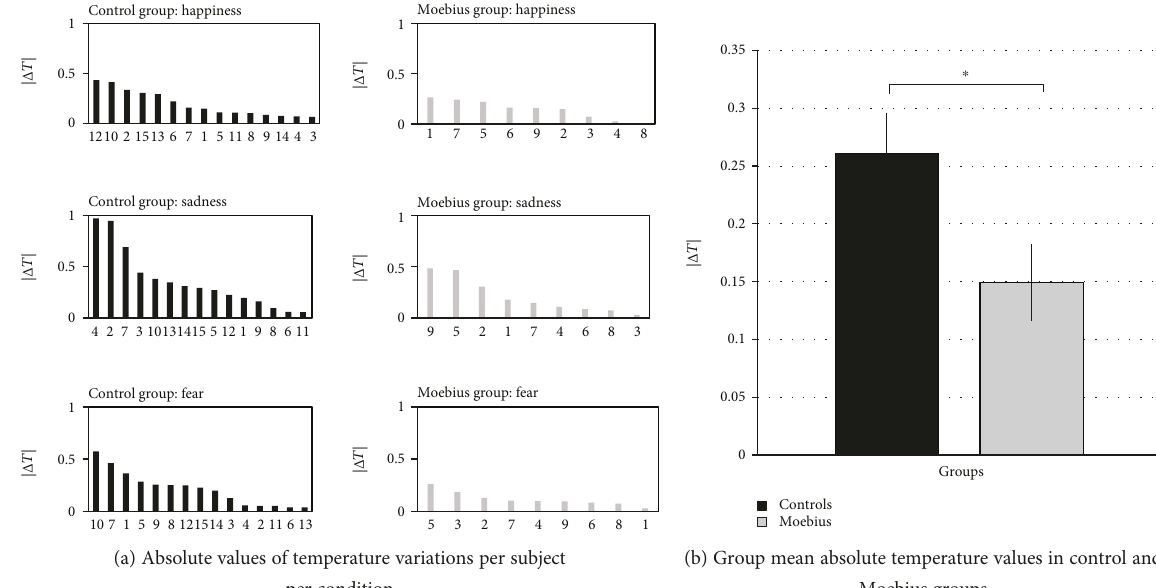
Figure 4: (a) Absolute value of the change in temperature from baseline per participant during each of the experimental conditions. Moebius participants exhibit a lower thermal modulation compared with control participants. (b) Group mean absolute temperature values in control and Moebius participants. Control participants have signi fi cantly more intense thermal modulation compared with Moebius participants. Means and standard errors (SE) are reported for both control and Moebius groups.